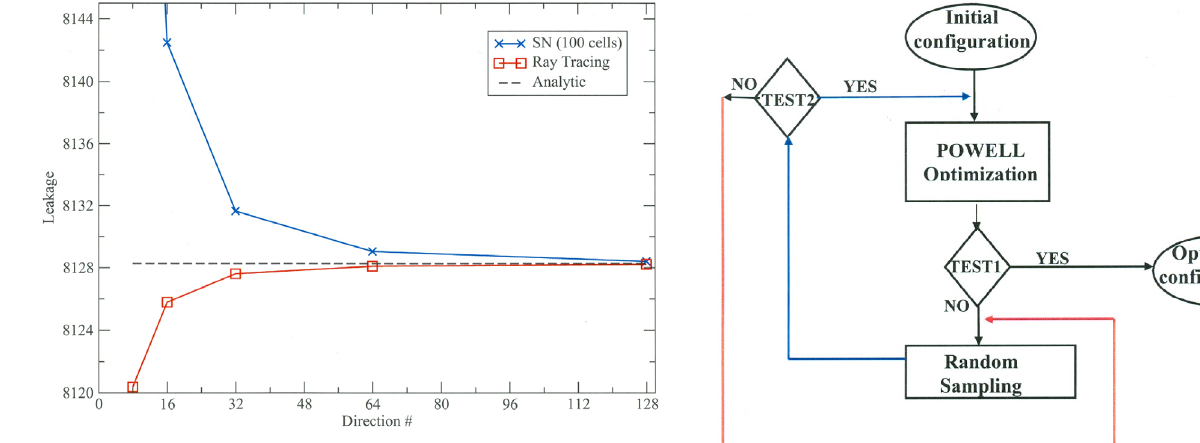
Fig. 10. Convergence to the analytic solution of the ray tracing and S N leakage calculations with the number of directions.